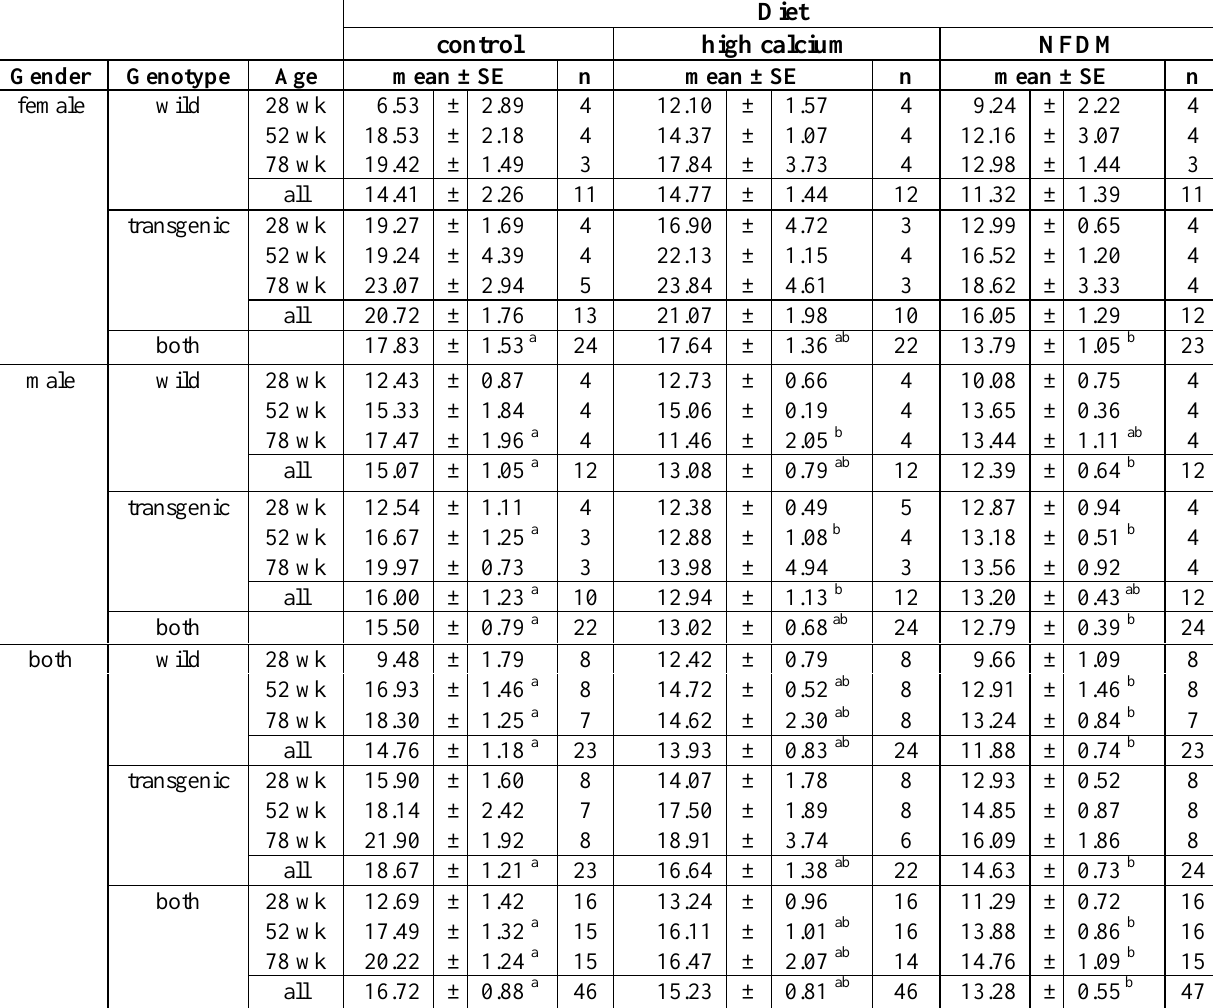
Table 2. Percentage of total body fat calculated from inguinal, retroperitoneal, perirenal, subscapular and epididymal (in male) fat pads per body weight in aP2-agouti transgenic and wild-type mice fed control, high calcium or NFDM diets at 28, 52 and 78 weeks of age. Values are expressed as mean ± SE. Non-matching superscripts denote significant differences between diet groups, p < 0.05. Diet control high calcium NFDM Gender